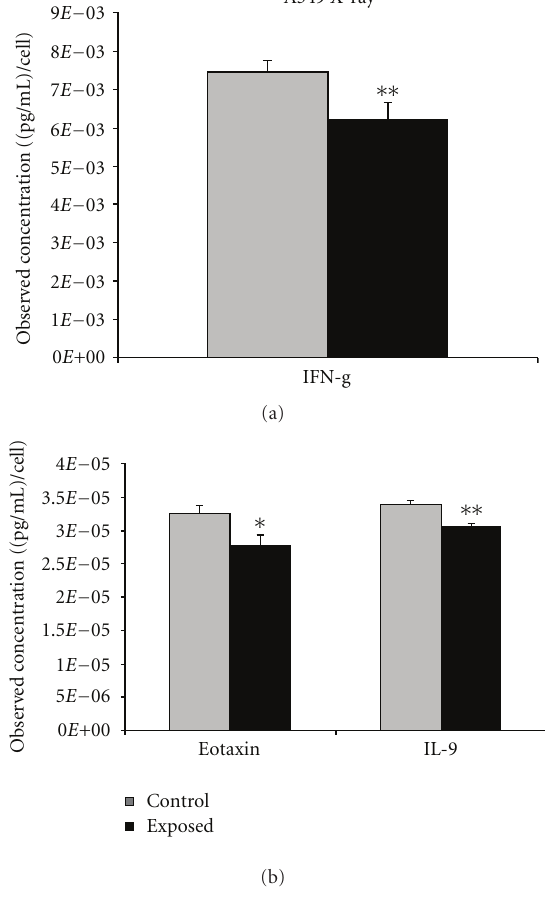
Figure 2: A549 cells were seeded into Mylar dishes and exposed to X-radiation at 0 and 1.5Gy. A Bio-plex cytokine assay was performed quantitating 27 di ff erent cytokines, and the results showing statistical significance between control and exposed groups are presented. ∗ represents P < 0 . 05, ∗∗ represents P < 0 . 01, and ∗∗∗ represents P < 0 . 001, n = 5 biological replicates performed in duplicate. Bars are plotted as cell count corrected means ±